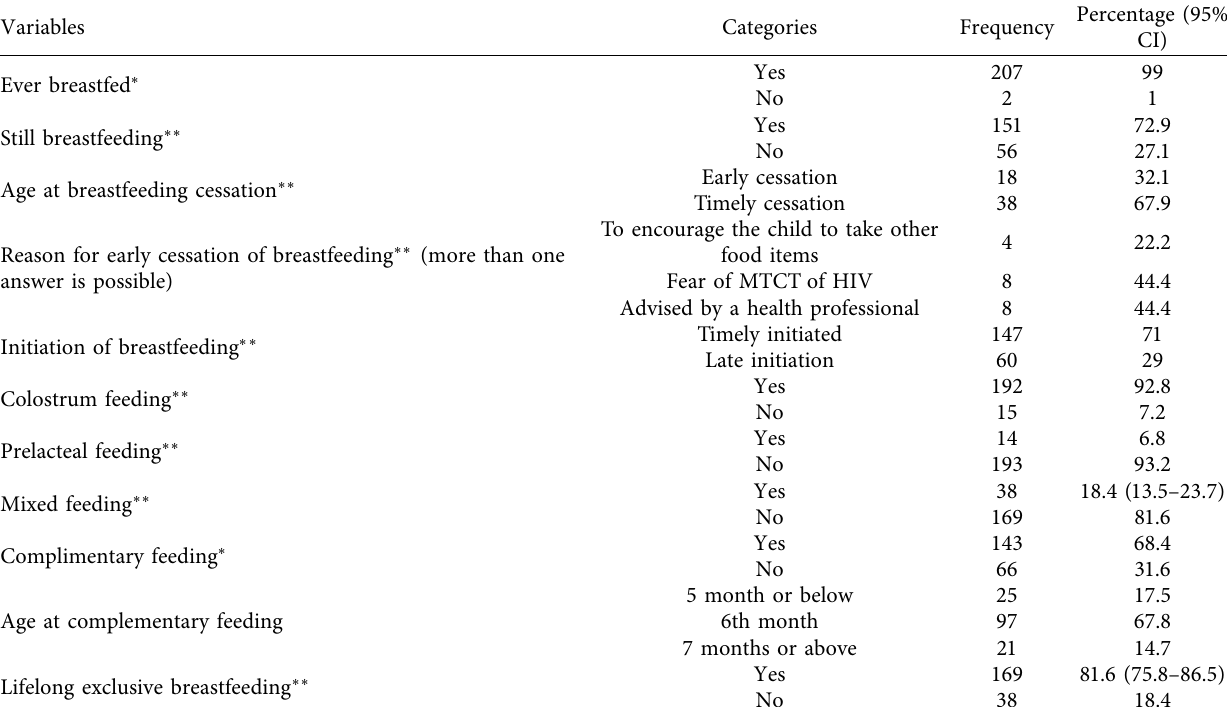
Table 3: Infant feeding practice of HIV-positive mothers with a child below 18 months of age, SNNPR, Ethiopia, 2019. Variables